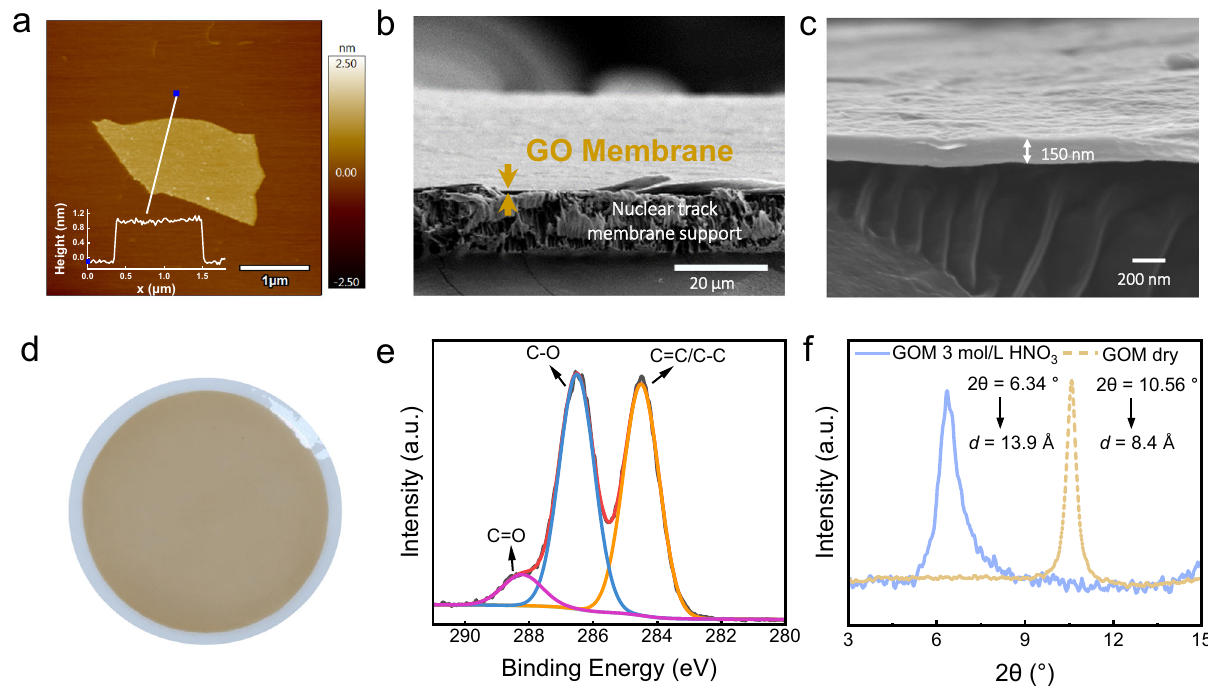
Fig. 2 | Characterization of GO nanosheet and GOM. a AFM image of GO nanosheet, inset is the height pro fi le across the white line. b Cross-sectional SEM image of the GOM on the support membrane. c Cross-sectional SEM image of the